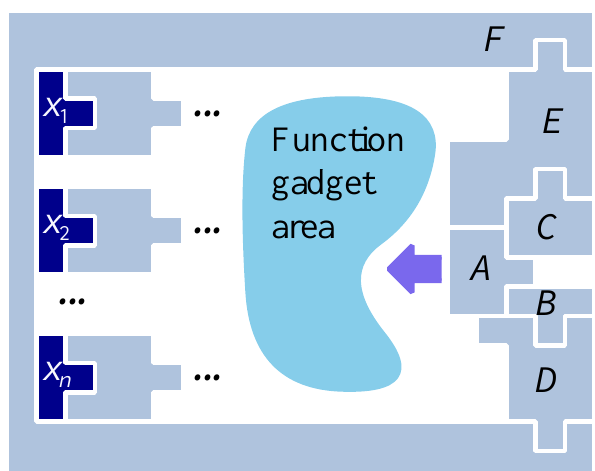
Figure 3. Outline of the